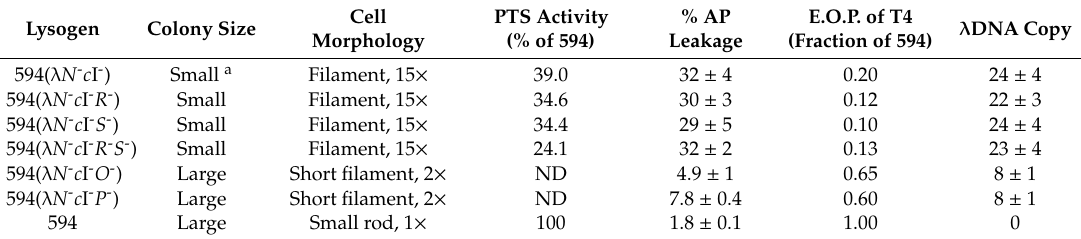
Table 7. Properties of polylysogens of the general type 594( λ N - cI - X -